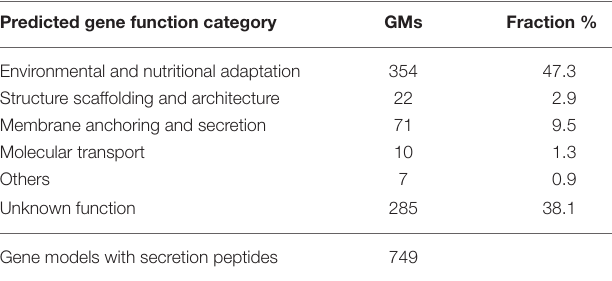
TABLE 6 | AFUMN secretome GM